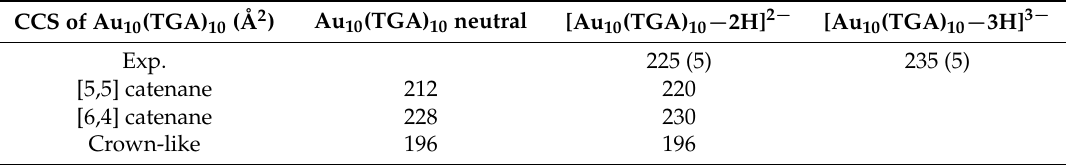
Table 1. Experimental and calculated collision cross-section (CCS) values for three isomers of Au 10 (TGA) 10 NCs are given. The influence of charge has been experimentally determined (error bars are in brackets). For this purpose, the trajectory method has been used [27]. The DFT structures obtained for [Au 10 (TGA) 10 − 2H] 2 − are given in Figure S5 in the Supplementary Materials. CCS of Au 10 (TGA) 10 (Å 2